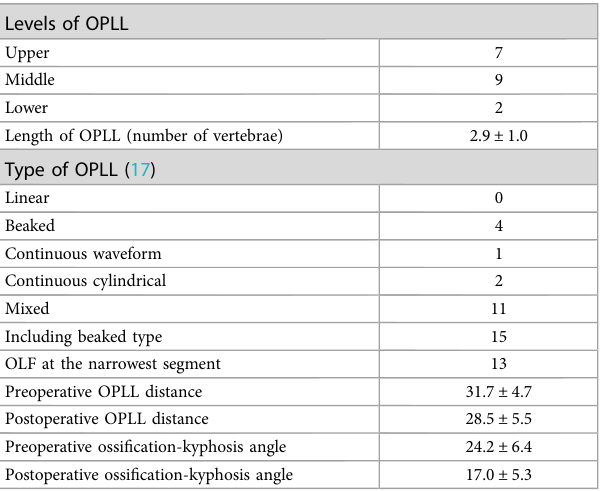
TABLE 4 Radiographic evaluation of the